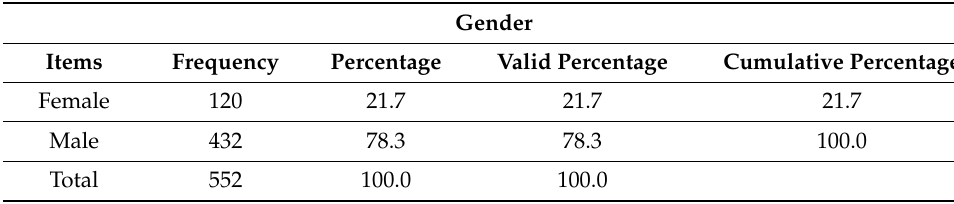
Table 2. Demographic information of the respondents by